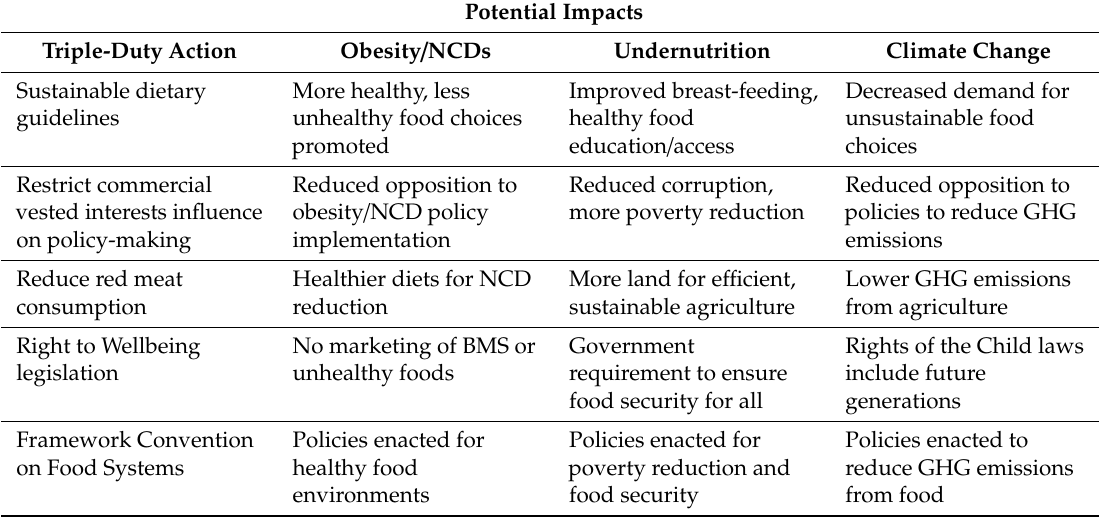
Table 1. Examples of triple-duty actions for the food systems to benefit action on obesity, undernutrition and climate change